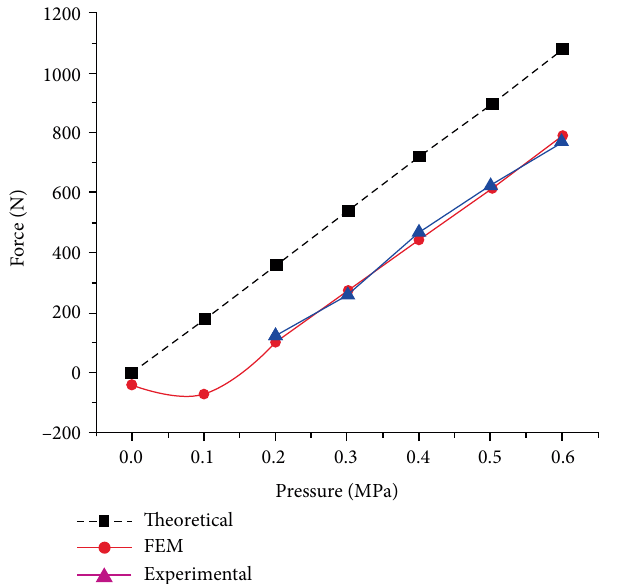
Figure 7: Comparison of initial diameter, inflated diameter, and equivalent diameter under different pressures at the contraction of